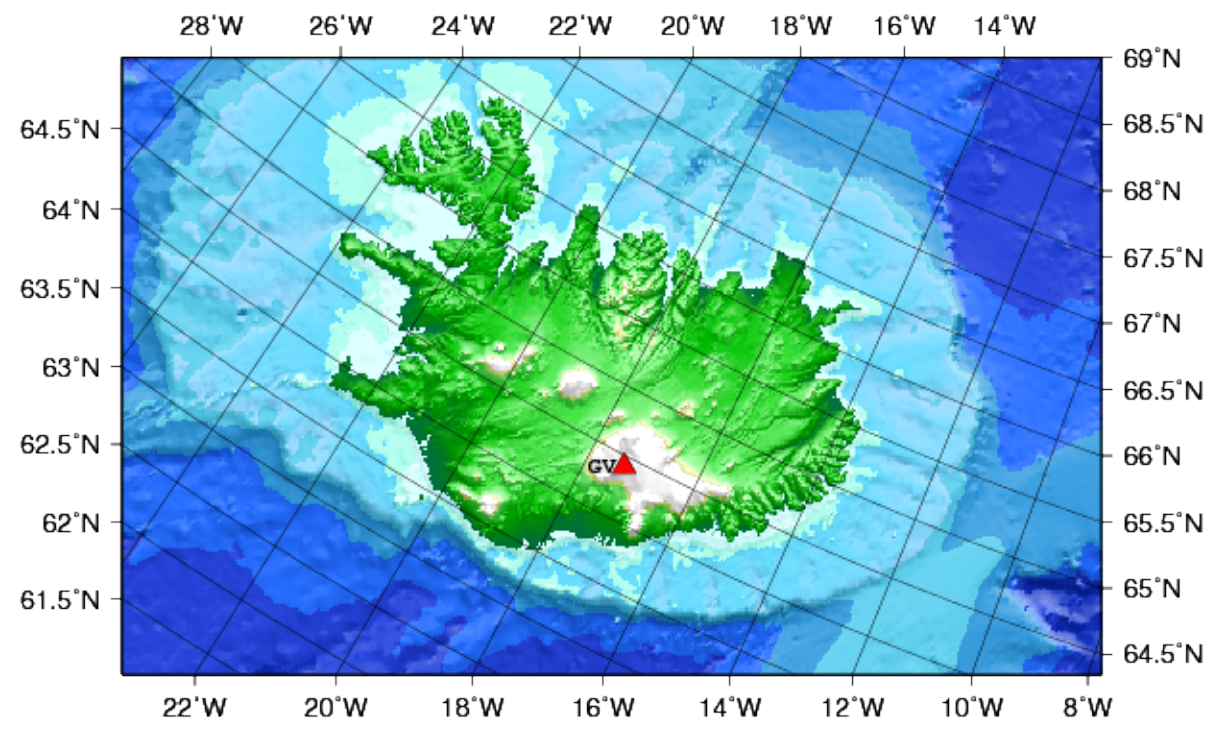
Figure 10. Location of the Grimsv¨otn Volcano (red